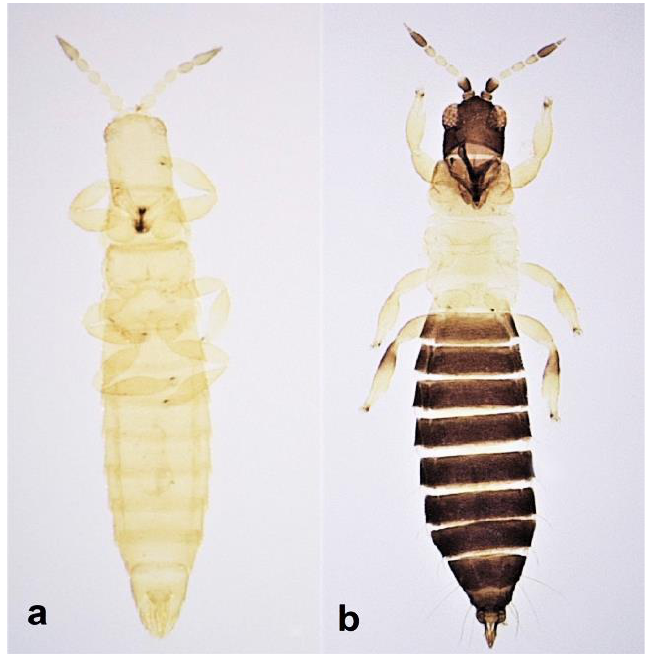
Figure 24. Male habitus: ( a ) yellow body colour; ( b ) body bicoloured.